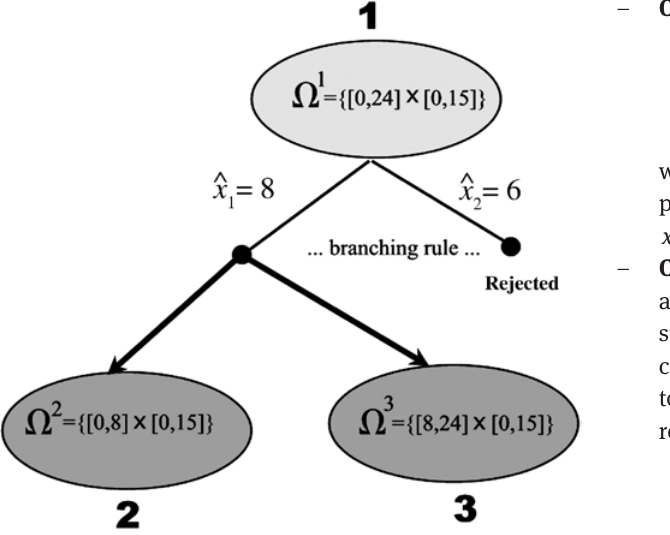
Figure A1: Branch-and-bound decision tree of Example A1.